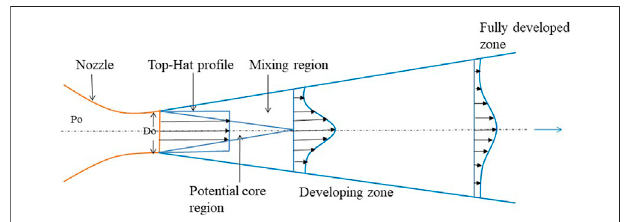
FIGURE 1 | Schematic representation of jet fl ow fi